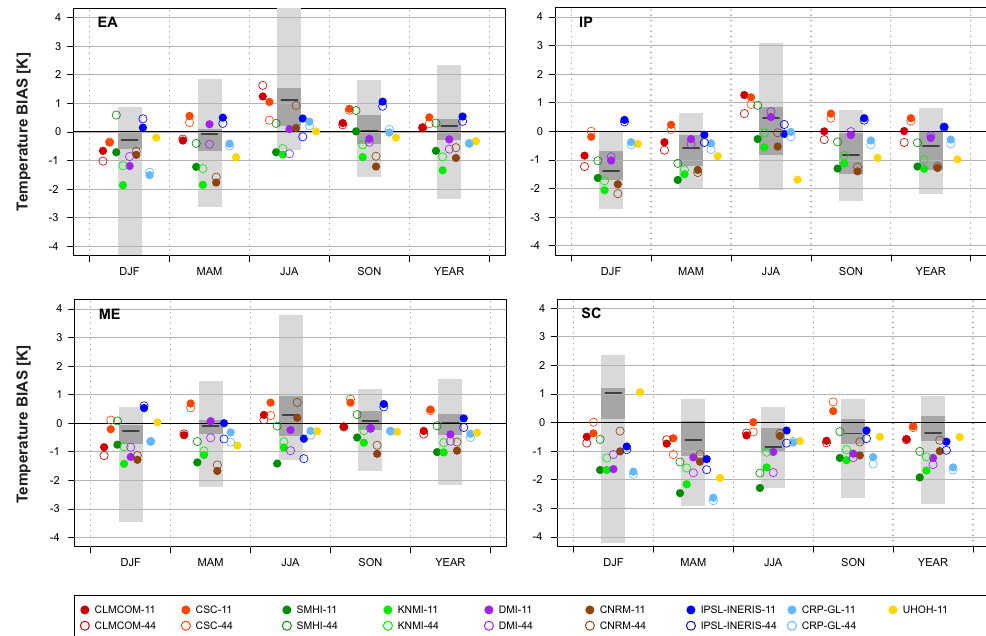
Figure 5. Mean seasonal and annual temperature bias (BIAS; K) for the EUR-11 (filled circles) and the EUR-44 ensemble (open circles) and for subdomains EA, IP, ME and SC (see Fig. B1 for subdomains AL, BI, FR and MD). The gray bars denote the BIAS range of the ENS-22 ensemble: entire range in light gray, interquartile range (corresponding to eight models) in dark gray and median as solid line.